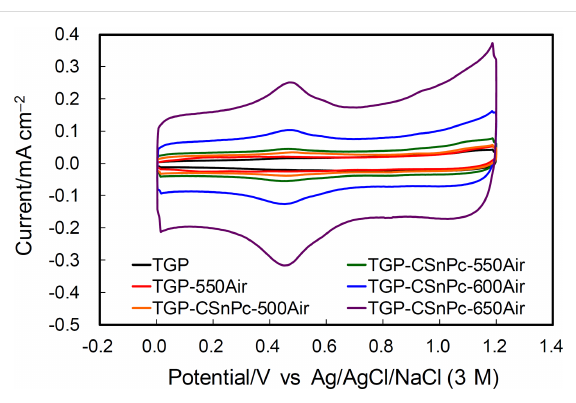
Figure 4: Cyclic voltammograms in Ar-saturated 2 M H 2 SO 4 at 25 °C for TGP, TGP-550Air, and TGP-CSnPc- T Air ( T = 500, 550, 600 and 650 °C). The reference electrode was Ag/AgCl/NaCl (3 M). The counter electrode was carbon cloth. Scan rate: 50 mV·s − 1 .